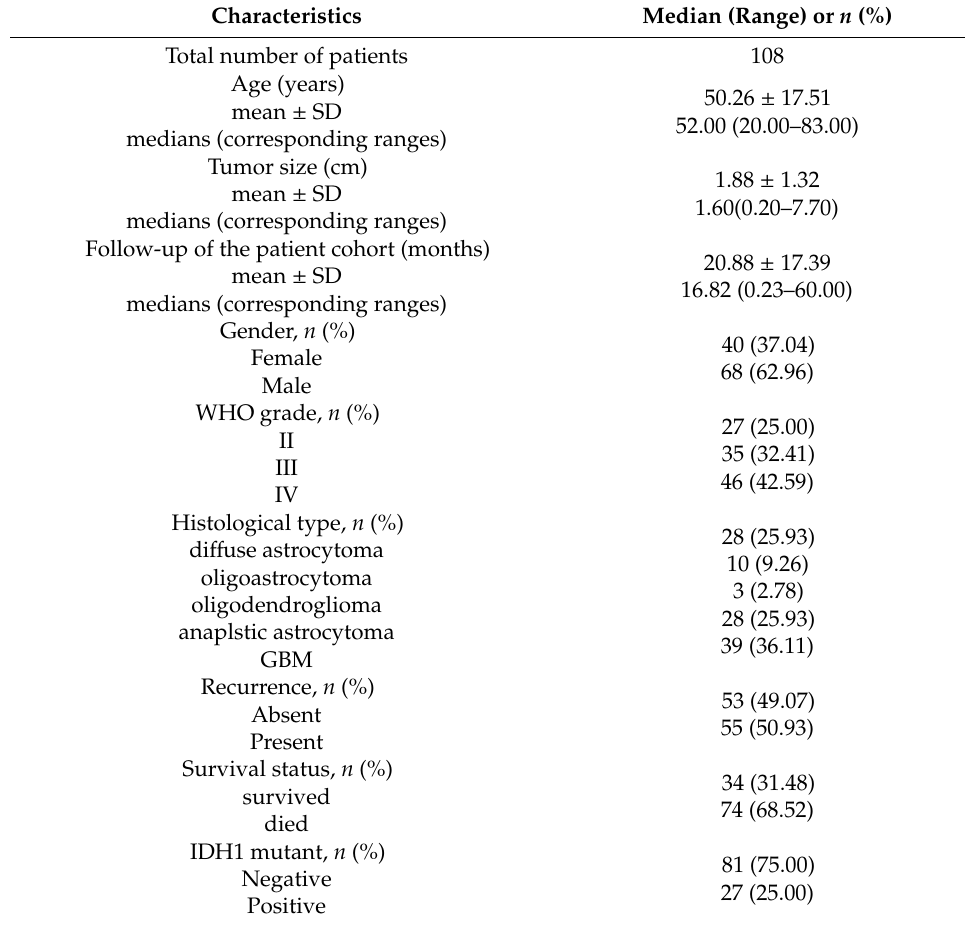
Table 1. Patient baseline characteristics ( n =